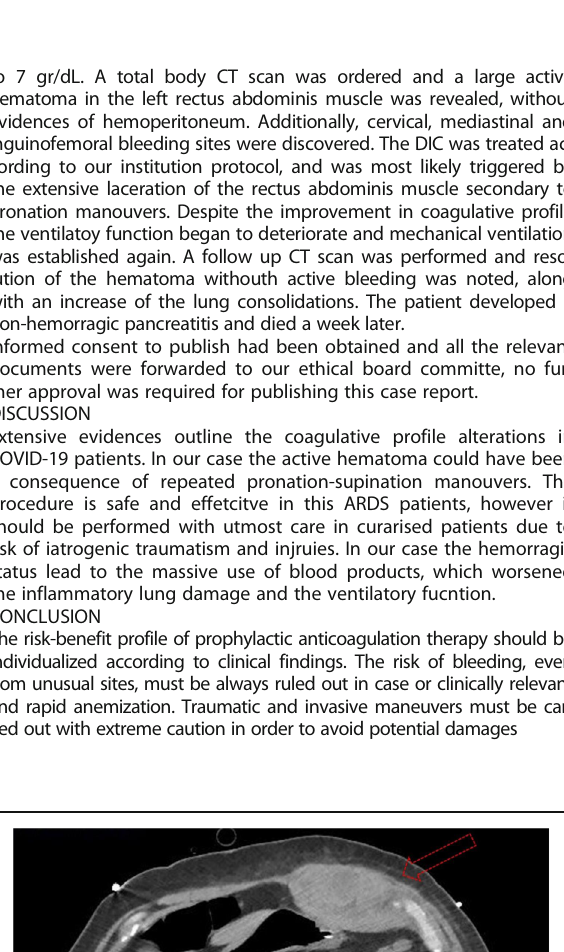
Table 1 (abstract A124). Summary of the included studies. RCT; Ramdomized Controlled Trial; POS: Prospective Observational